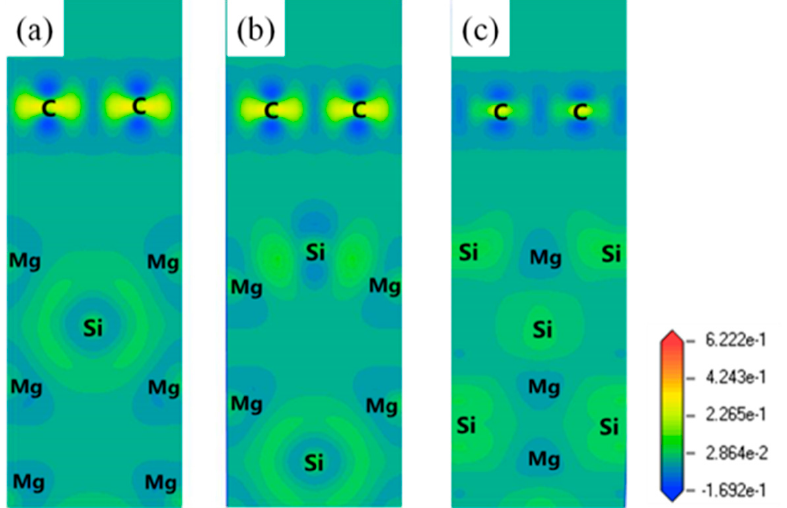
Figure 4. The charge density difference diagram for Mg 2 Si (001)/Gr (0001) interfaces: ( a ) Mg- termination; ( b ) Si-termination-center-sited; ( c ) Si-termination-top-sited.